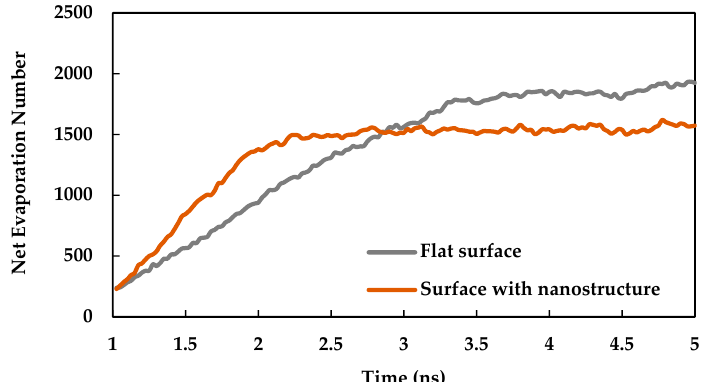
Figure 13. Net evaporation number as a function of time.